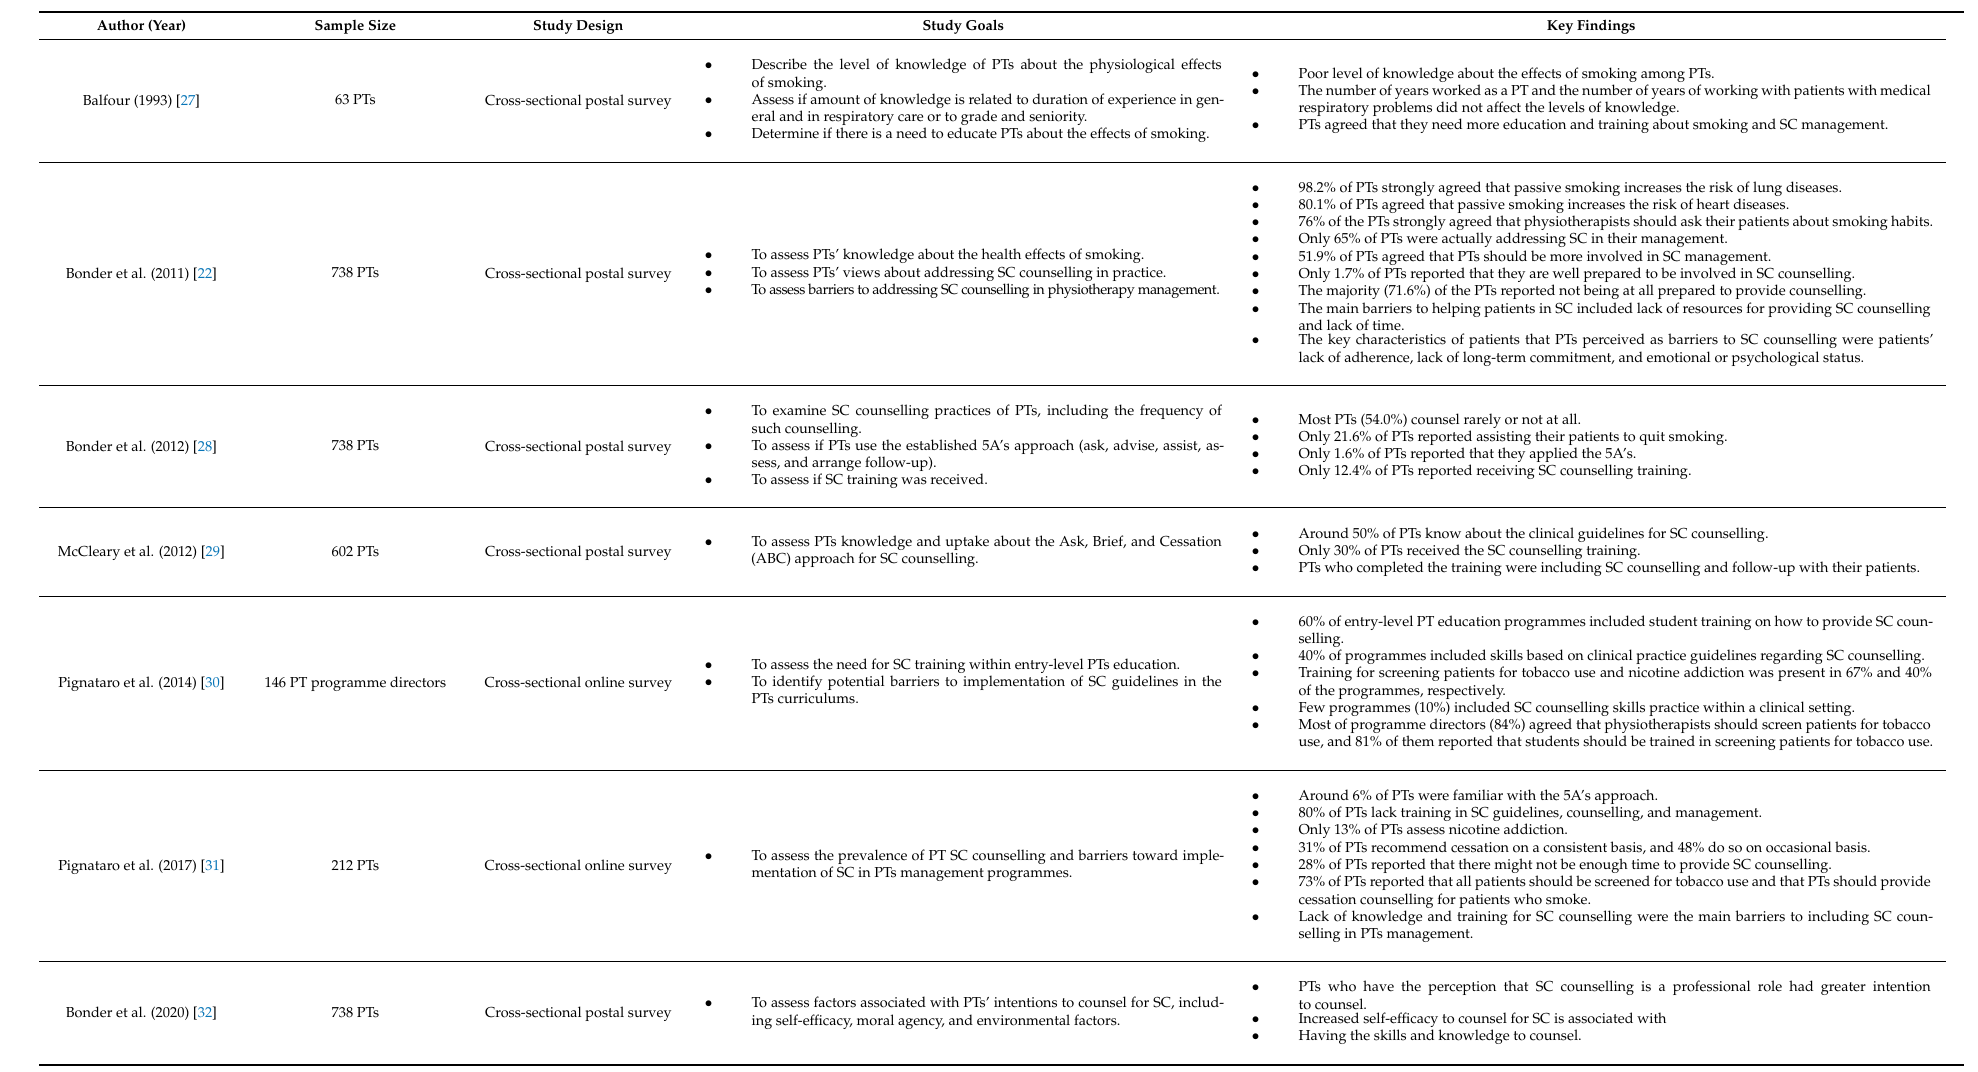
Table 2. Data extraction table for the included articles ( n =